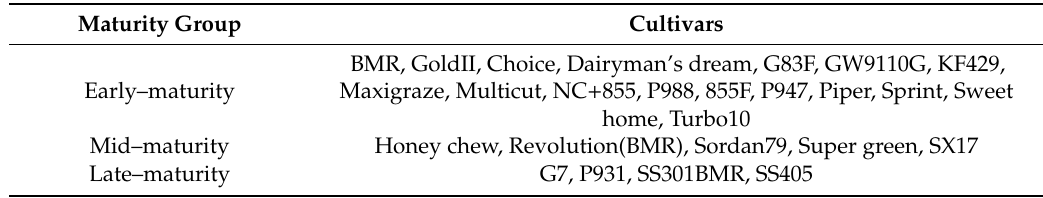
Table 1. Sorghum–sudangrass hybrid cultivar maturity groups.